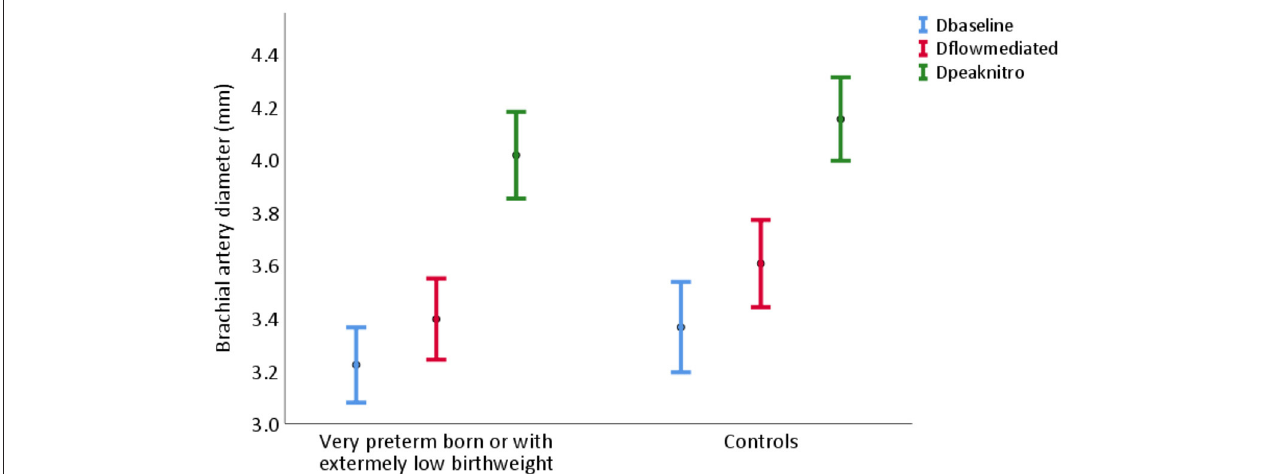
FIGURE 3 | Brachial artery diameter at baseline (blue), after flow-mediated dilatation (red), and after nitroglycerine induced dilatation (green) in young adults born very preterm or with extremely low birthweight (PB/ELBW) and term-born controls, presented as mean with 95% CI. Absolute flow-mediated dilatation was 0.17mm (95% CI 0.14, 0.21) in the PB/ELBW group and 0.24mm (95% CI 0.20, 0.28) in the control group. Dbaseline: brachial artery diameter at baseline; Dflowmediated: brachial artery diameter after flow-mediated dilatation; Dpeaknitro: brachial artery diameter after nitroglycerine induced dilatation.